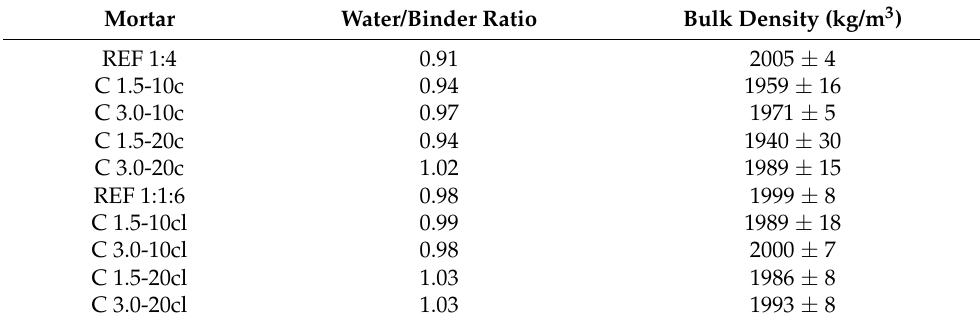
Figure 5. Dry bulk density of the hardened mortars. 3.3. Dynamic Modulus of Elasticity The dynamic modulus of elasticity was determined by resonance frequency over time, from 28 days until 365 days, and the results are presented Figure 6. Rendering mortars should be able to deform and accommodate the stresses without cracking. The modulus of elasticity measures the mortar’s ability to deform under stress. A low modulus of elasticity indicates that the mortars present a certain deformability, which may prevent cracking. Regardless of the binder used, it was noticed that the incorporation of fibers reduced the modulus of elasticity, which means that the modified mortars may behave in a more deformable way than the control mortar. At 365 days, cement-based mortar with 10% of 3.0 cm coir fibers presented the highest decrease of approximately 21% when compared to the reference mortar. In what concerns the cement-lime mortars, the fibers’ length and volume fraction seemed not to affect this reduction, since all the modified mortars presented similar values among them. The lowest modulus of elasticity was attributed to the C 1.5-10cl sample, which reduced approximately 19.5% compared to that of the REF 1:1:6, at 365 days.